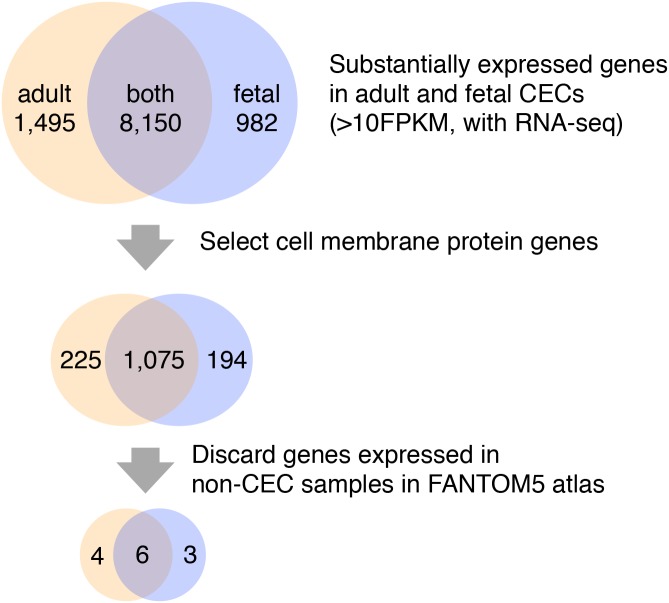
Bioinformatics analysis flow chartFPKM: Fragments Per Kilobase of exon per Million mapped fragments.